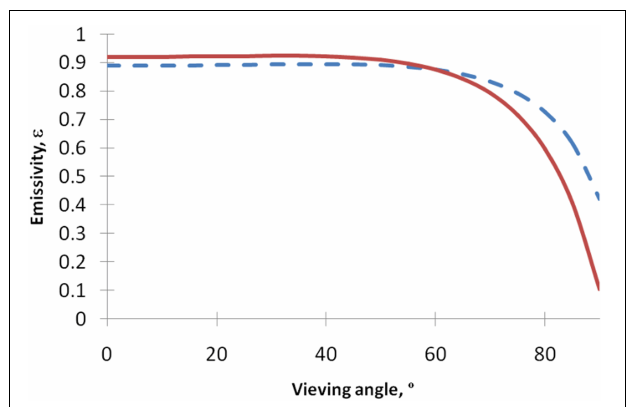
FIGURE 2 | Dependence of the emissivity on the viewing angle for several indexes of refraction. Index of refraction n = 1.5 (red solid line), n = 2 (dashed blue line). As the angle of viewing increases, the emissivity of the surface is reduced. Thus, for images acquired obliquely, the lower emissivity can lead to a reduction in the apparent temperature of the object in the